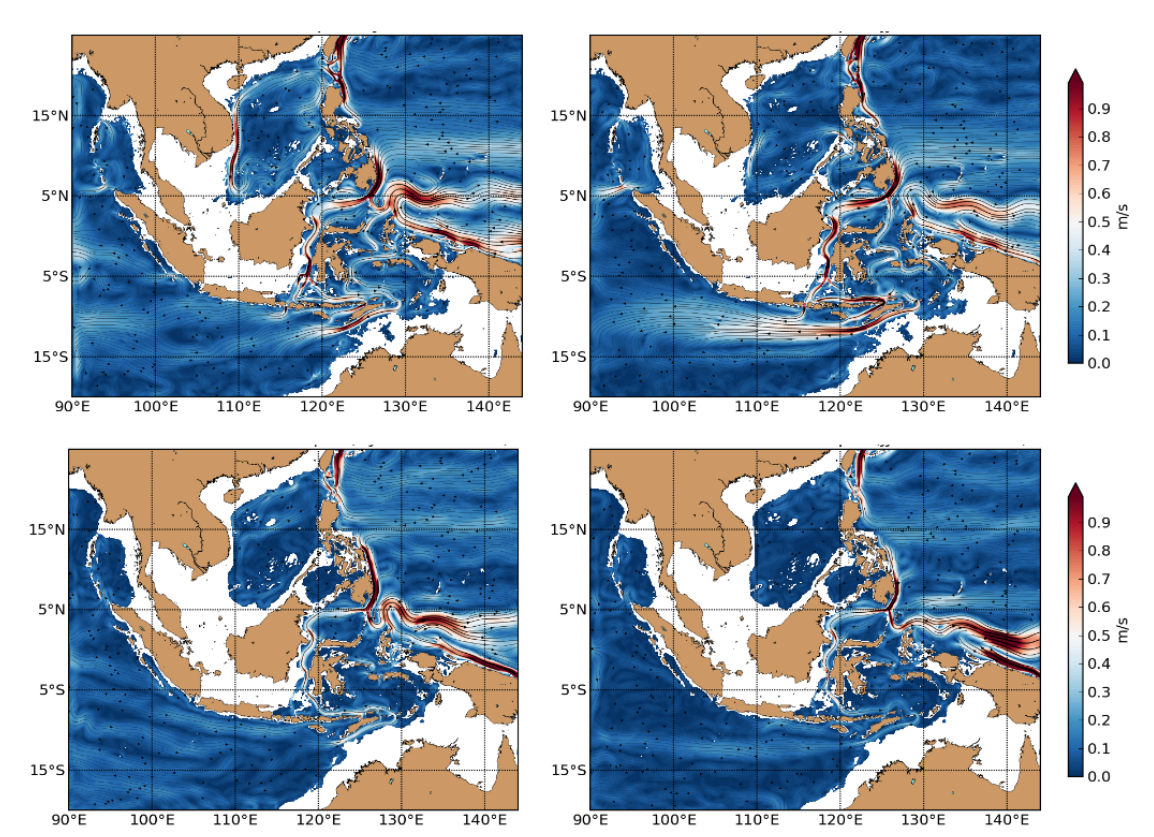
Figure 3. Mean circulation at 100m (top) and 300m (bottom) during boreal winter or DJF (left) and boreal summer or JJA (right) during the 2008–2013